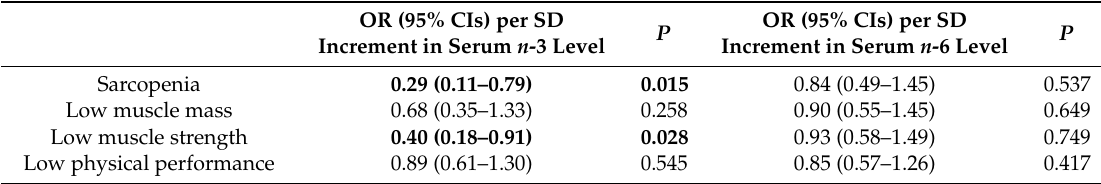
Table 2. Logistic regression analyses to determine the odds ratios for sarcopenia and related parameters according to serum levels of n -3 and n -6 fatty acids.